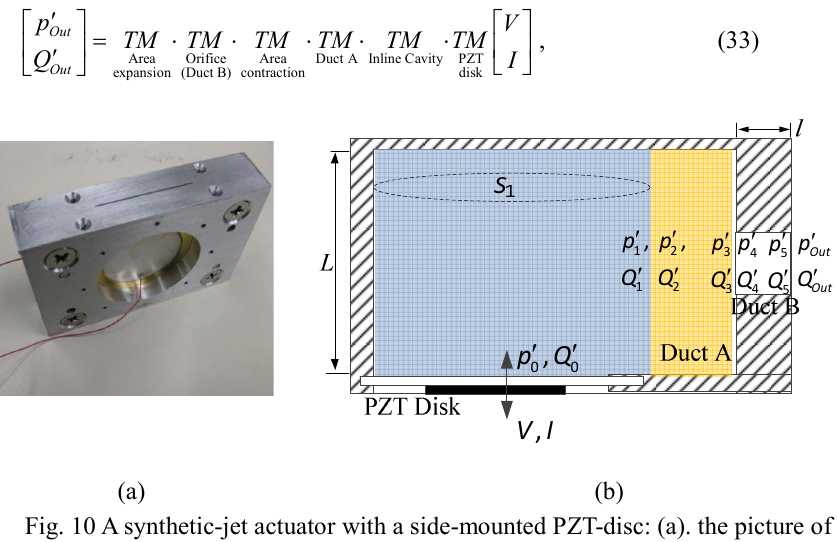
Fig. 10 A synthetic-jet actuator with a side-mounted PZT-disc: (a). the picture of the actuator; (b). the schematic used to derive the TM of the